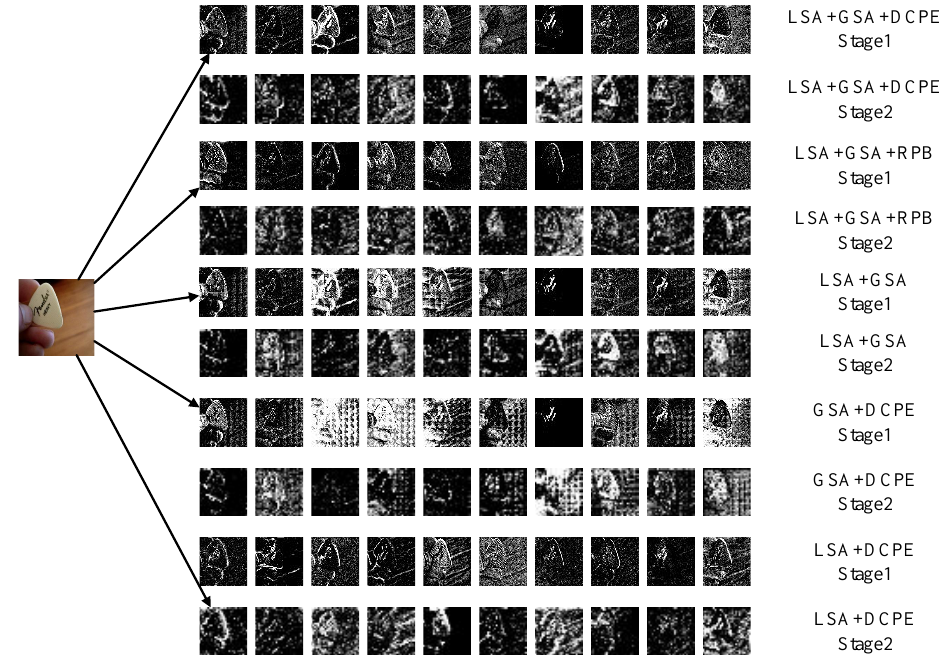
Figure A5. Another feature visualization of our network with different self-attention modules and position encoding modes. Only the outputs of the first two stages are